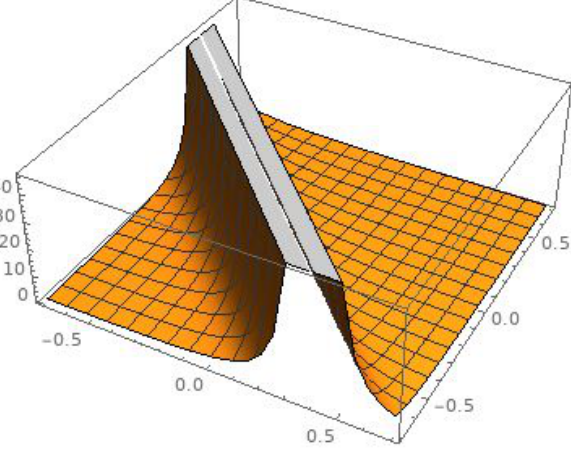
= 1, γ = 1, η = 1, η = 1 , C = 0 . (combined soliton 1 3 1 3